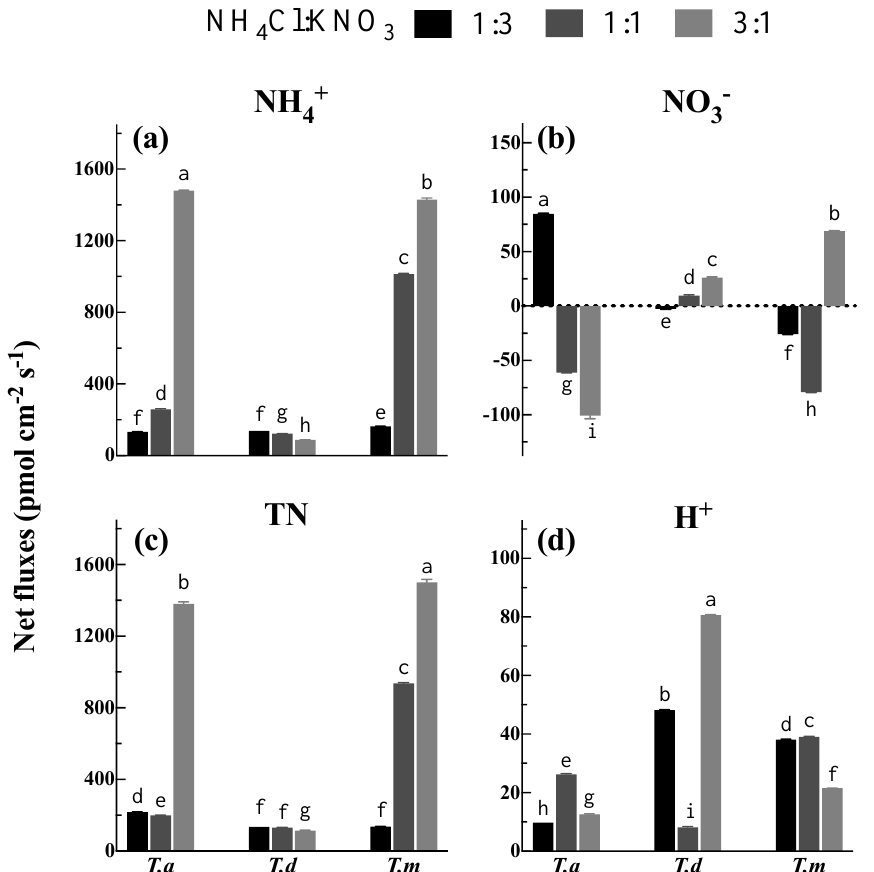
Figure 5. Net fluxes of NH 4+ ( a ), NO 3 − ( b ), total N ( c ) and H + ( d ) under different proportions of NH 4 Cl and KNO 3 . Bars indicate standard errors ( n = 8). Different letters indicate significant differences among the treatments according to Duncan’s Multiple Range Test at 5% level. T. a , T. d , and T. m represent T. ascendens , T. distichum and T. mucronatum , respectively.